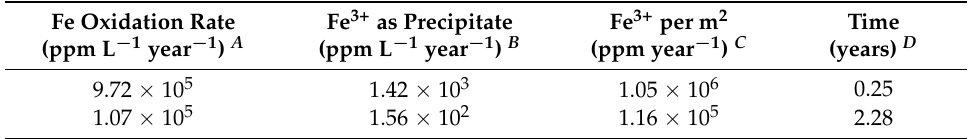
Table 2. Calculations for determining the range of time taken for the development of one gram of schwertmannite to form a lamination within a 1 m 2 area for TIF